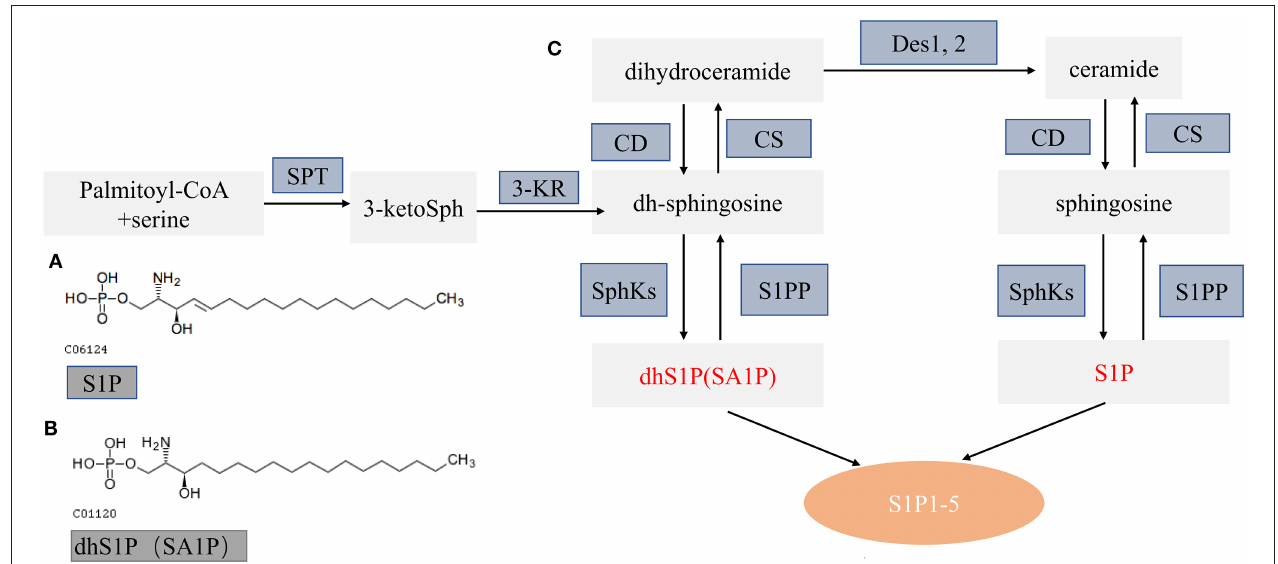
FIGURE 7 | Schematic diagram of sphingolipid metabolism. (A,B) The molecular structure of S1P and SA1P. (C) Model of sphingolipid metabolism: this schematic model depicts the de novo pathway of sphingolipid metabolism. S1PP, sphingosine 1-phosphate phosphatase; SphKs, sphingosine kinases; S1P 1–5, S1P receptors 1–5; SPT, serine palmitoyl transferase; KR, ketosphingosine reductase; CS, ceramide synthase; CD, ceramidase; S1P, sphingosine 1-phosphate; dhS1P, dihydrosphingosine 1-phosphate; DES, dihydroceramide desaturase. Altered metabolites in this study are in red